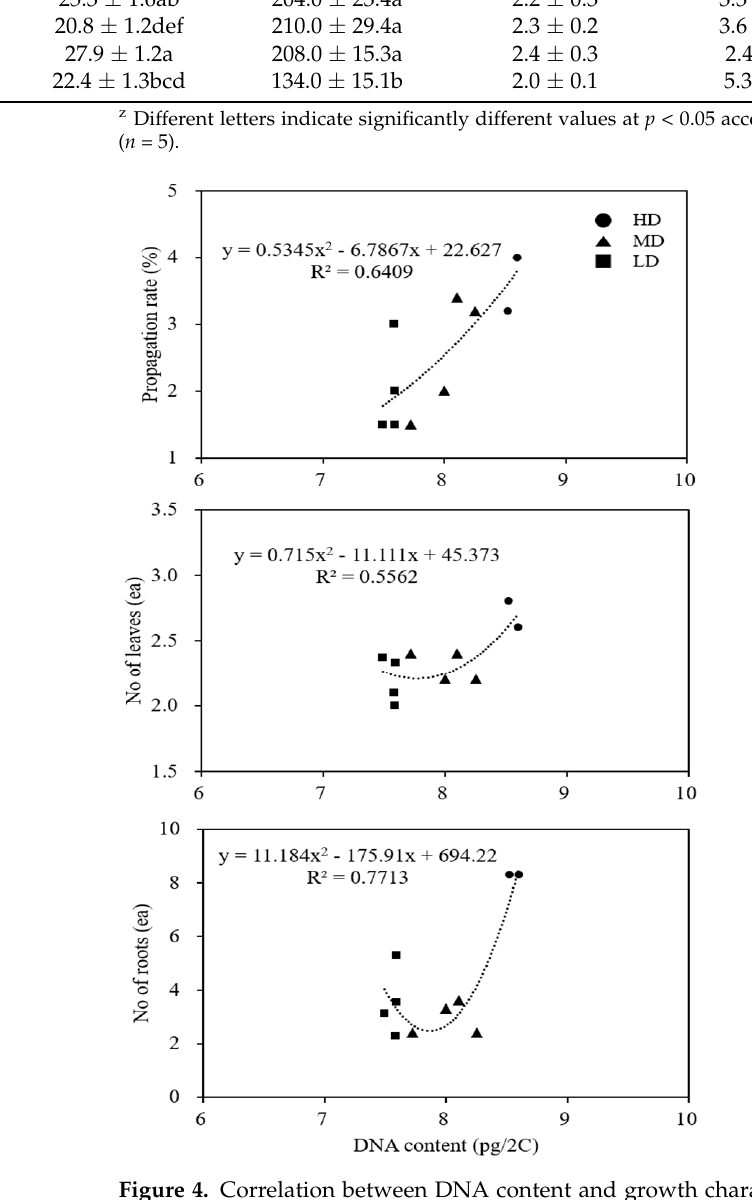
Figure 4. Correlation between DNA content and growth characteristics of ten clones of Cnidium officinale : HD, cones with high DNA content; MD, clones with moderate DNA content; and LD, clones with low DNA content.